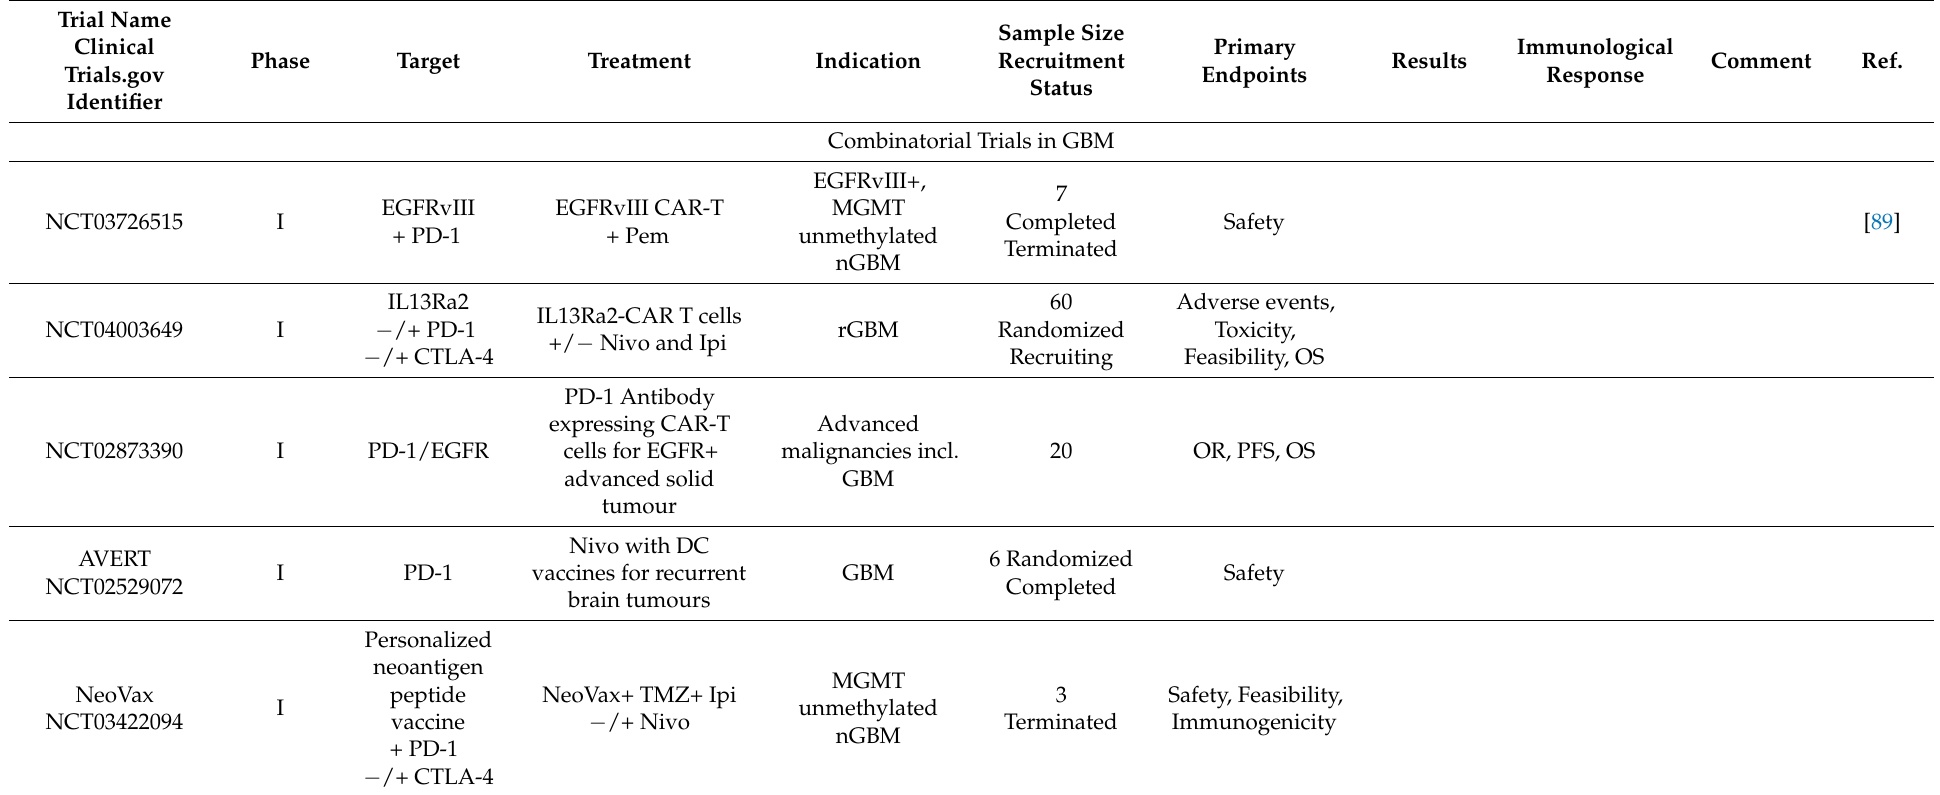
Table 4. Combinatorial clinical trials in